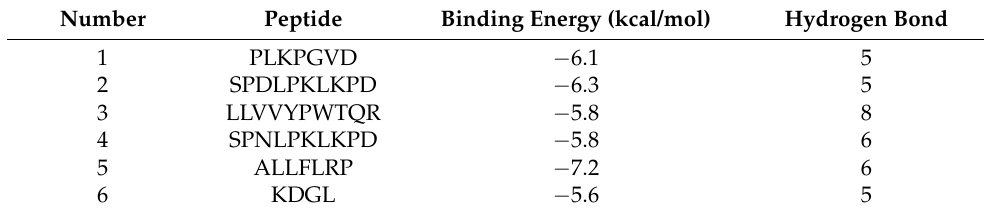
Table 4. Molecular docking